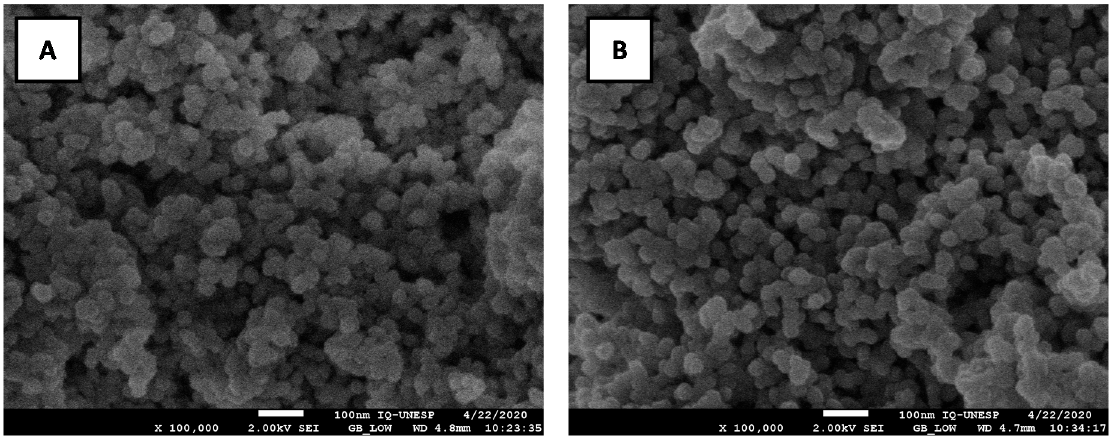
Figure 1. SEM FEG of ( A ) S 1 and ( B ) S 1 -[Eu(dbm)].